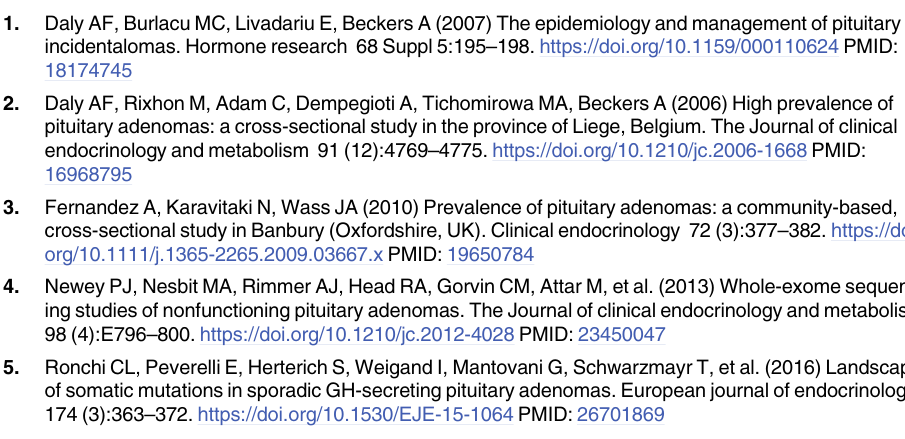
S1 Table. Description of all somatic variants of PitNET